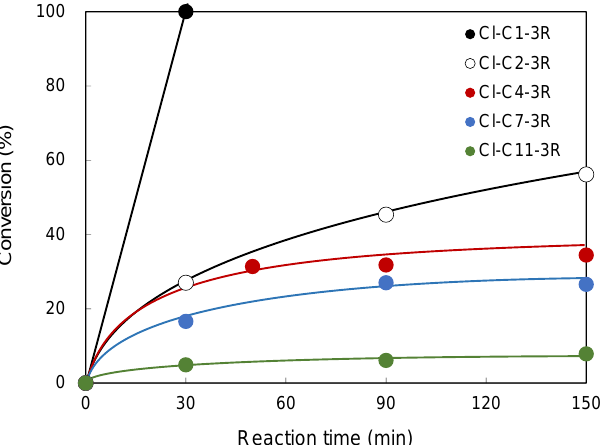
Figure 4. Time dependence of conversion of Cl-Cn-3R to BS-Cn-3R. (A) n = 1 (black filled circles), (B) n = 2 (black open circles), (C) n = 4 (red filled circles), (D) n = 7 (blue filled circles) and (E) n = 11 (green filled circles).